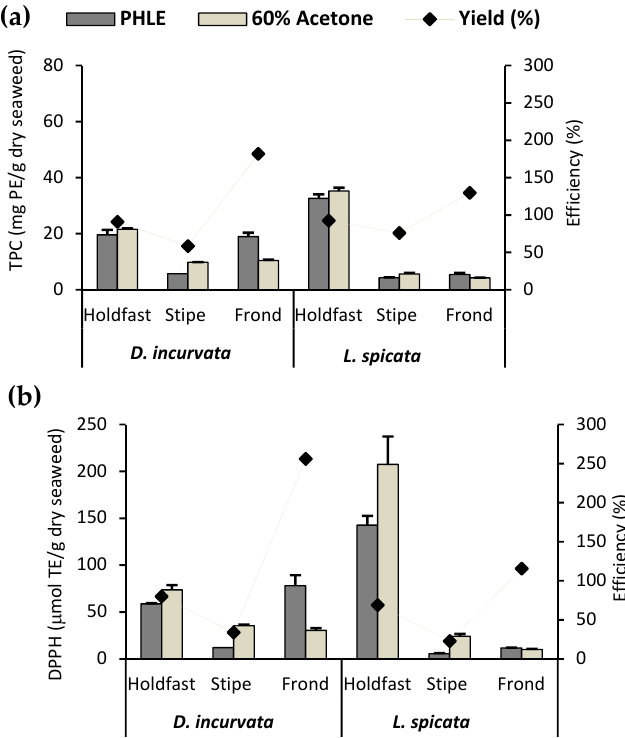
Figure 1. Effectivity of PHLE against 60% acetone in the extraction of phlorotannins from the main anatomical parts of D. incurvata and L. spicata : holdfast, stipe, and frond. ( a ) The TPC (mg PE/g dry seaweed) and ( b ) the antioxidant capacity, measured as DPPH RSA ( µ mol TE/g dry seaweed), were analyzed in PHLE and 60% acetone extracts obtained from a randomly selected sample per each species/thallus part combination. PHLE-TPC and PHLE-AC efficiencies were determined as a ratio of the 60% acetone extracts’ values. Bars represent the means ± SD of three extractions carried out per each sample and method, and dots correspond to the mean efficiencies of PHLE.